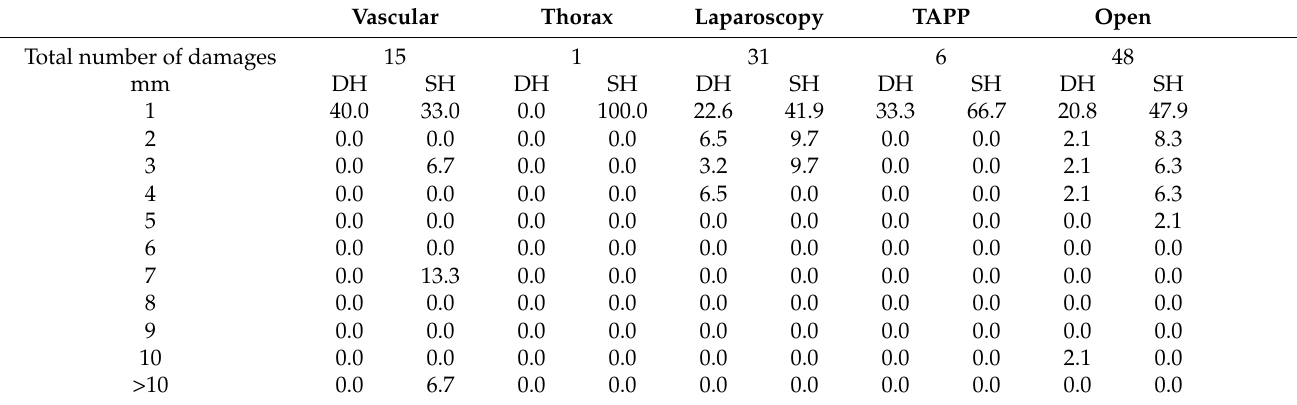
Table 5. Percentage occurrence of certain sizes of damage in relation to the total number of